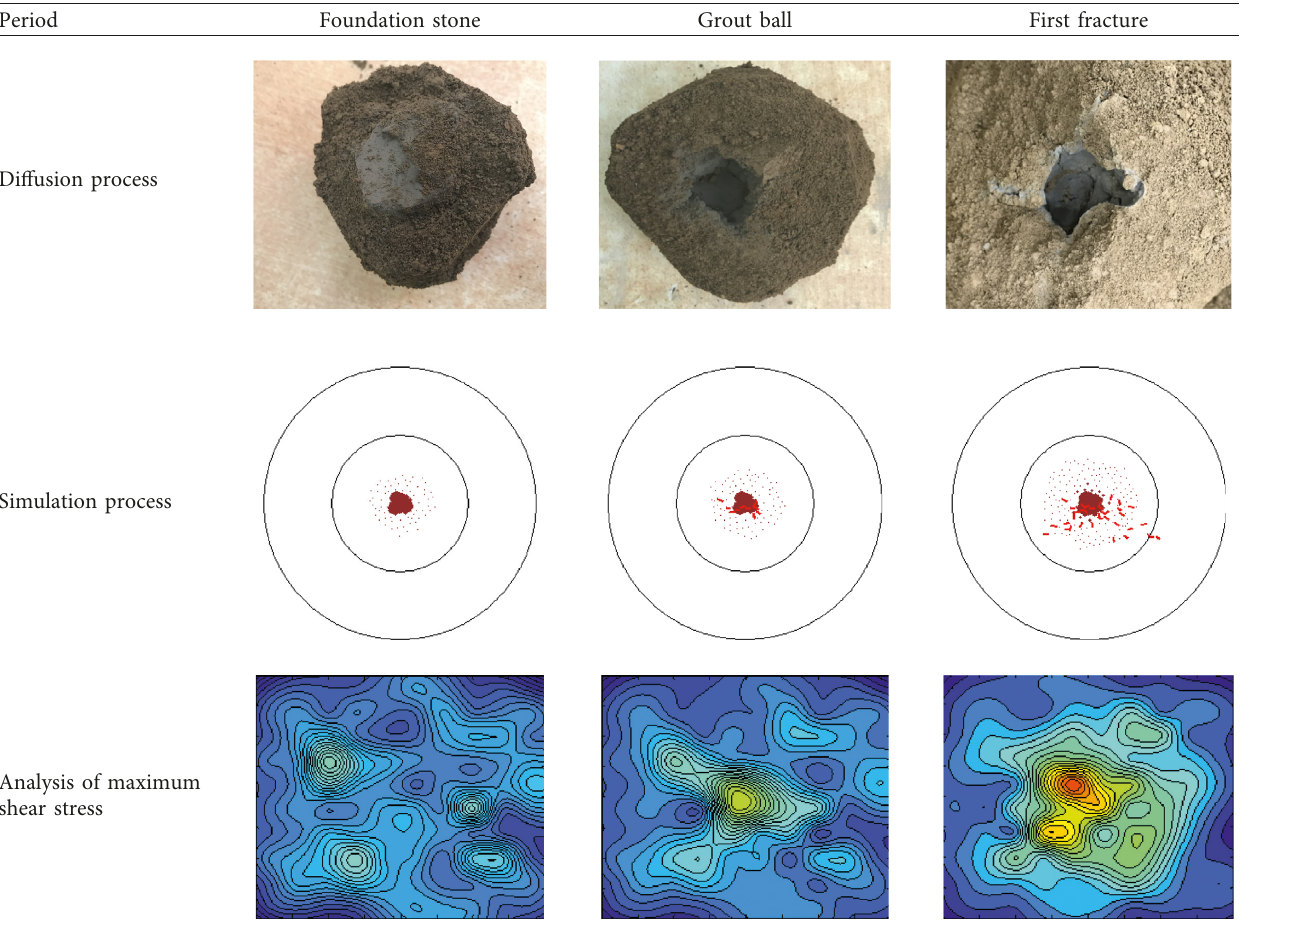
Table 4: Initial stage test and simulation